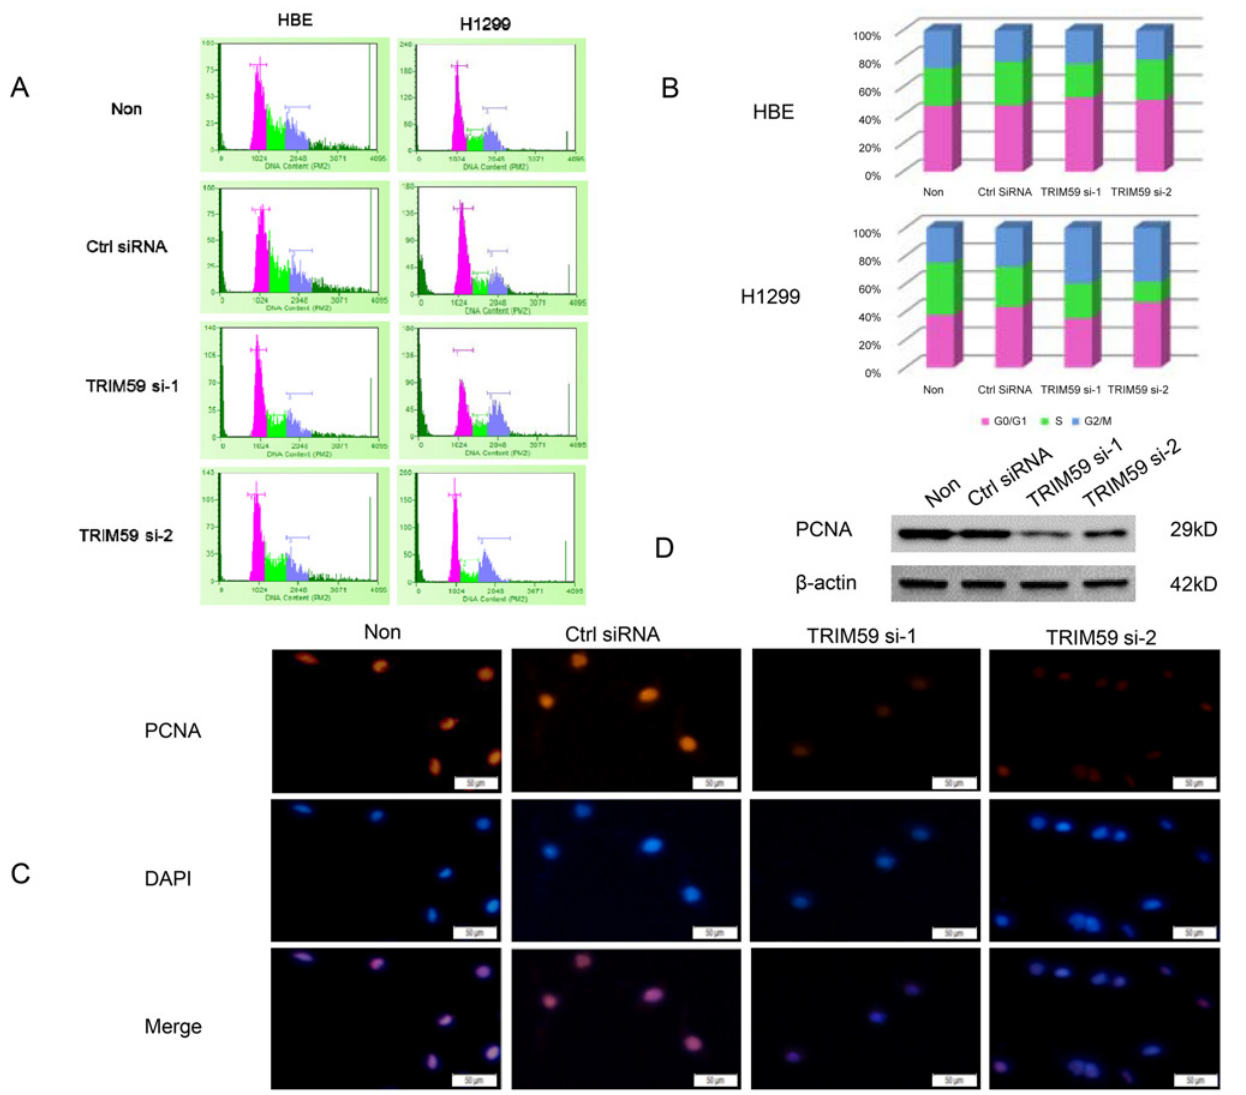
Fig 4. Knocking down of TRIM59 arrests NSCLC cell cycle in G2 phase. HBE and H1299 cells were transiently transfected with TRIM59 siRNA-1, TRIM59 siRNA-2, control siRNA or untransfected were cultured in RPMI 1640 with 10% FBS for 48 hrs. (A) Adherent cells were collected and cell cycle analysis was done by flow cytometry. The inserts showed the proportion of cells for each phase and are marked with different colors (pink: G0/G1 phase, green: S phase, and gray: G2/M phase). (B) The ratio of the cells in each phase was counted. (C) H1299 cells were fixed and stained with anti-PCNA antibody (red) and DAPI (blue). (D) The protein expression levels of PCNA in H1299 cells were checked by western blot.